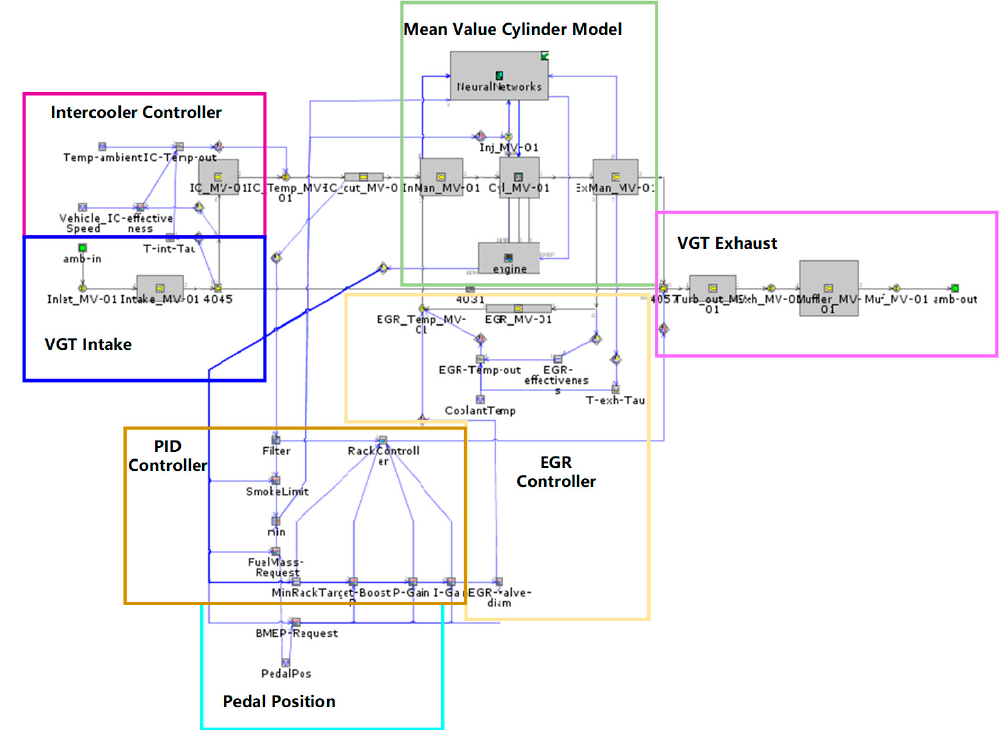
Figure 6. The GT-SUITE model layout of the 6 cylinder 3 L VGT-equipped diesel.